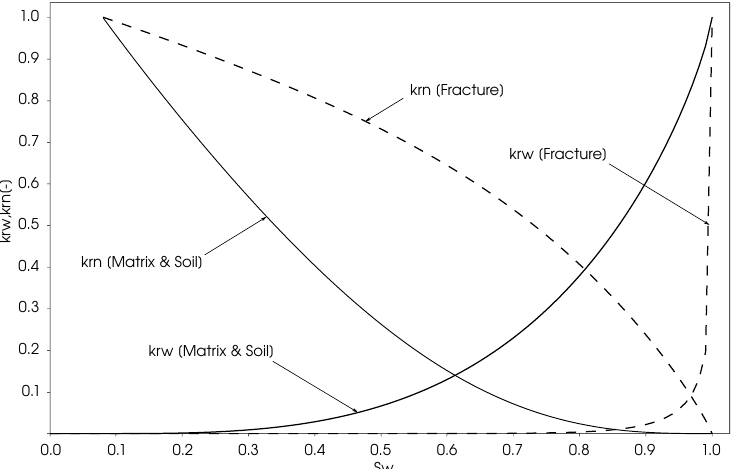
Figure 11. Relative permeability curves assigned to rock matrix and fracture in model